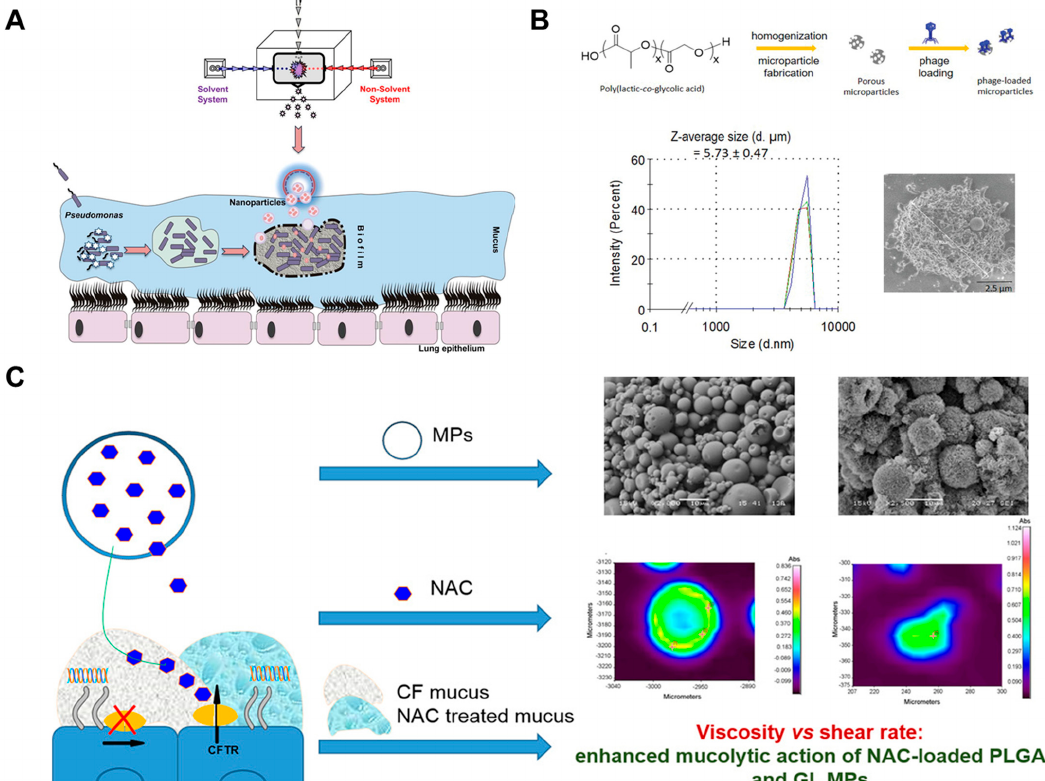
Figure 4. ( A ) Ciprofloxacin − loaded PLGA NPs against CF P. aeruginosa lung infections. Reproduced with permission from [144]. ( B ) Schematic diagram and characterization of fabrication and